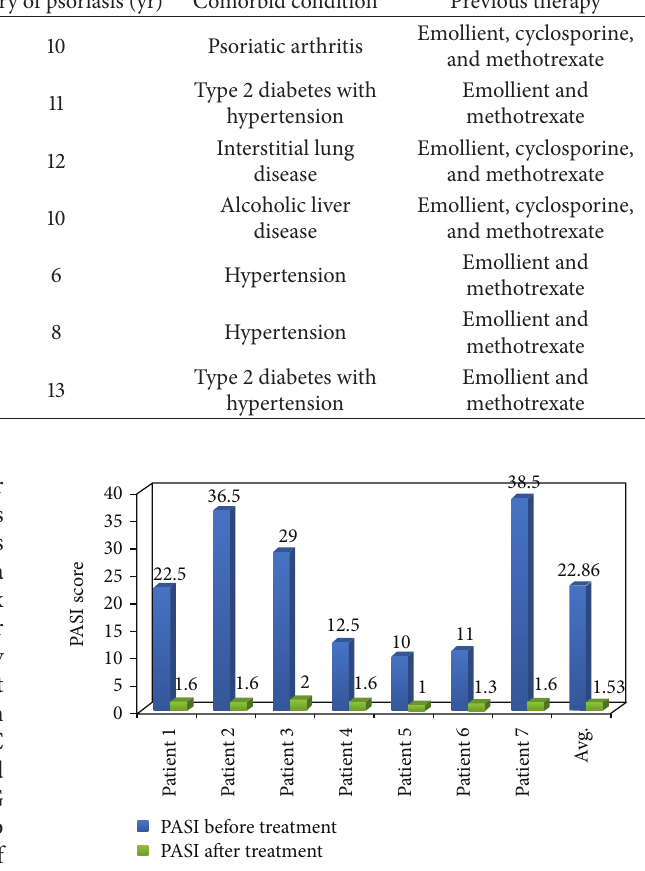
Figure 1: Effect of Itolizumab treatment on PASI score of patients.